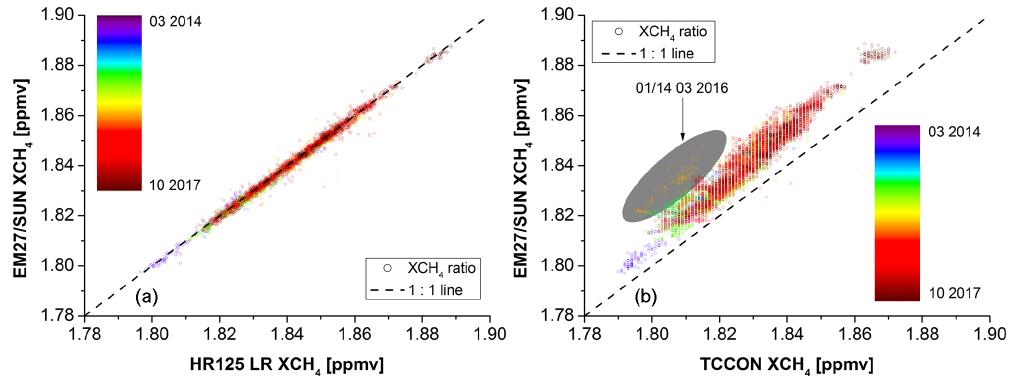
Figure 7. (a) shows the XCH 4 comparison between EM27/SUN and HR125 LR. The colorbar denotes the date of the measurement; the dashed line is the 1 : 1 line. In (b) the comparison with TCCON is shown. The shaded area encloses measurements from 1 and 14 March 2016. For these days the ratio is significantly different with respect to the remaining data set (see text for discussion).